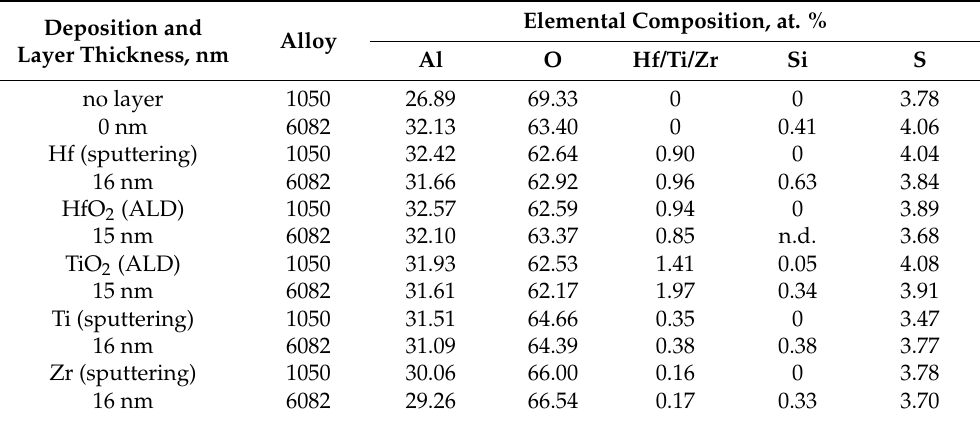
Table 1. EDS analysis of deposited nanolayers of group IVB elements on anodic coatings, adapted from [19].